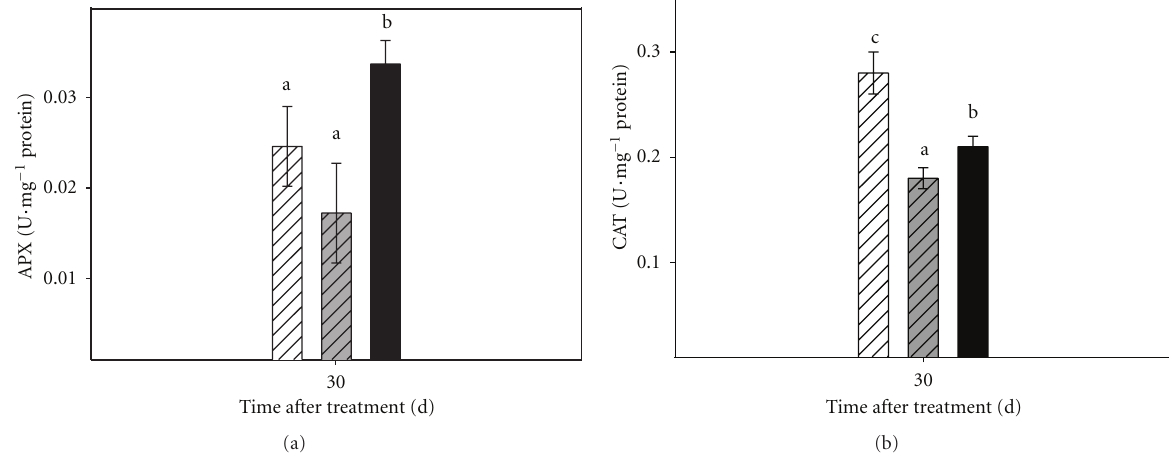
Figure 6: E ff ect of osmotic stress on enzymatic activity in micropropagated Carrizo citrange shoots. (a): APX activity; (b): CAT activity. Control plants (white bar), plants cultured under moderate (grey bar) or severe (black bar) osmotic stress conditions Each point corresponds to the average ± standard error of six independent determinations. Di ff erent letters denote statistical significance at P <